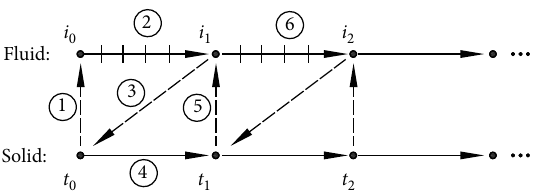
Figure 4: Fluid-thermal-ablation loosely coupling